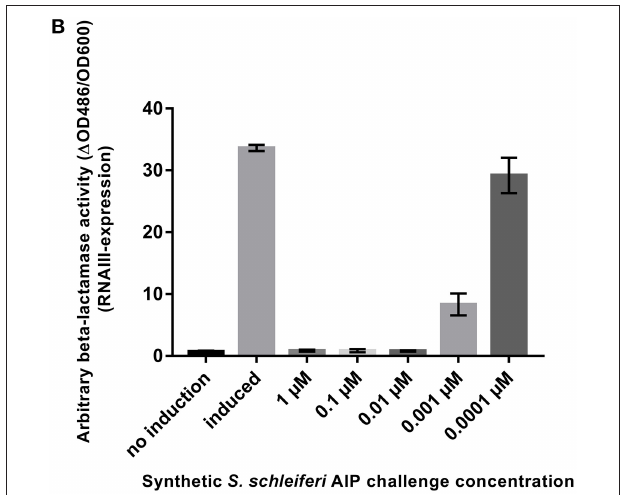
FIGURE 4 | S. schleiferi AIP interferes with S. aureus agr . (B) P3-blaZ expression recorded from S. aureus RN10829(P2-agrA:P3-blaZ)/pagrC-I (WT) when the inducing AIP-I containing supernatant (10%) is challenged for 45 min with different concentrations of synthetic S. schleiferi AIP at indicated concentrations. No induction and AIP-I containing supernatant alone were included as controls. Each bar represents the average of 3 biological replicates and the error bars represent the standard